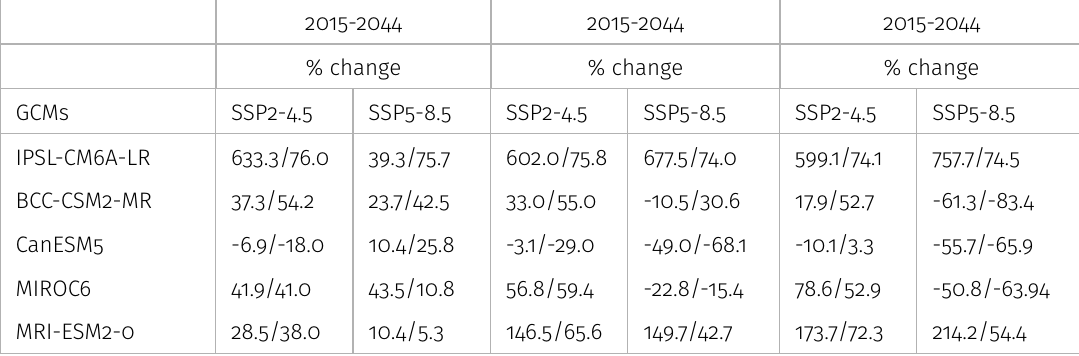
Table I. Relative change in streamflow/percent volume using five different GCMs with two SSPs-RCPs and three future